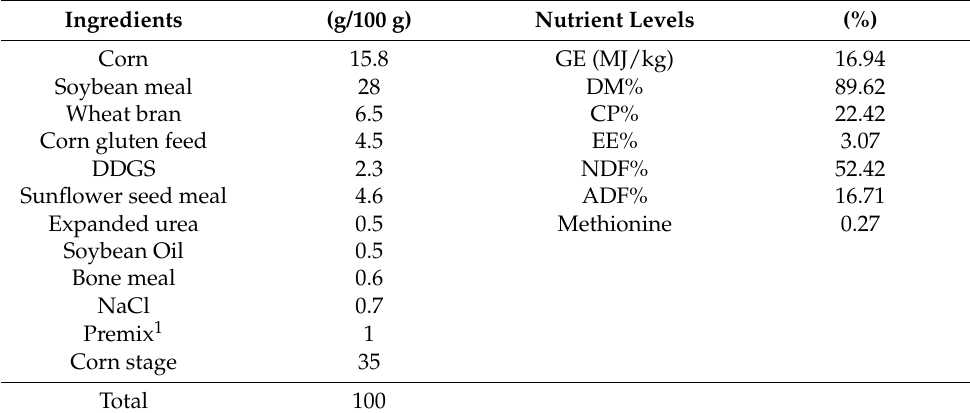
Table 1. Basic dietary composition and nutrient levels (dry matter